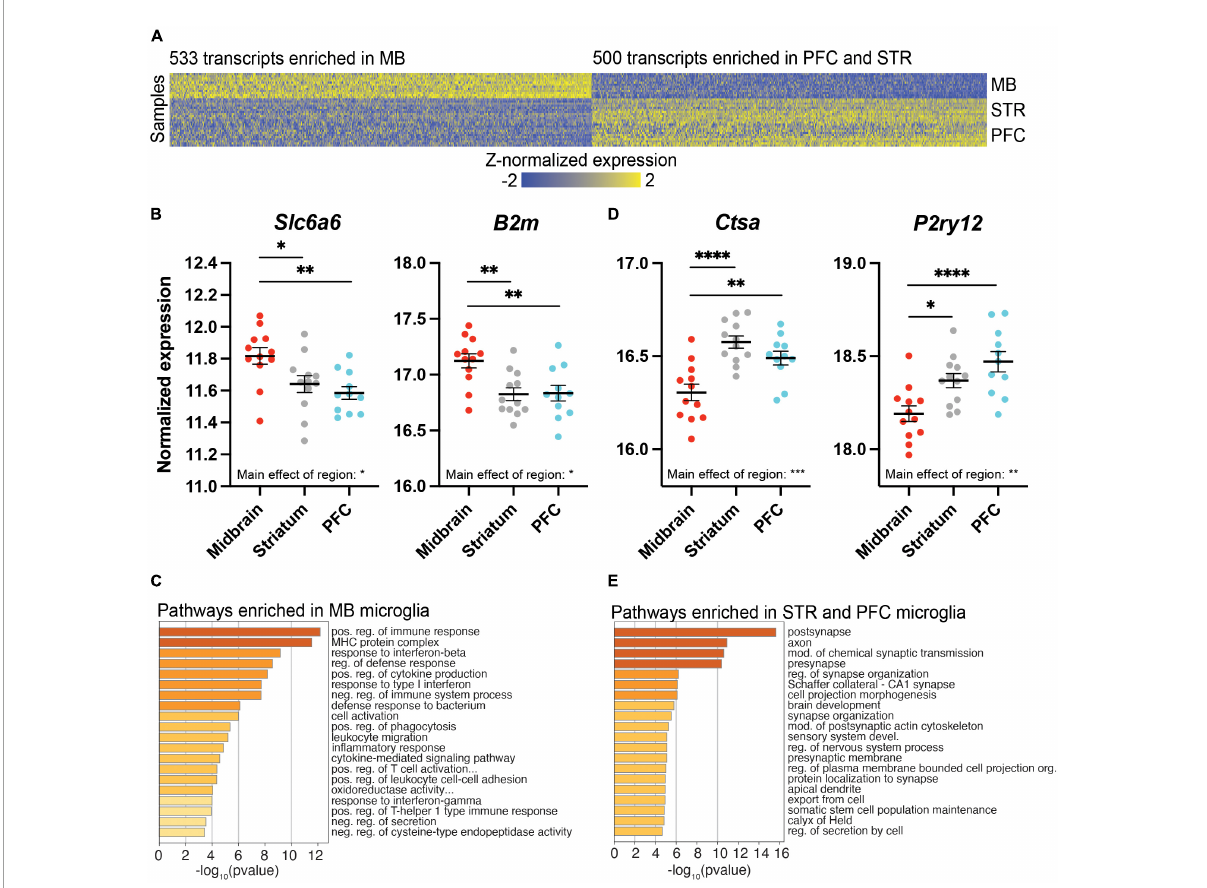
FIGURE3 Differentially expressed (DE) transcripts that distinguish the midbrain (MB) from the prefrontal cortex (PFC) and striatum (STR). (A) Heatmap of DE transcripts between MB and both PFC and STR. The 533 transcripts more highly expressed in MB compared to both PFC and STR are indicated on the left of the heatmap, while the 500 transcripts expressed at lower levels in MB compared to both PFC and STR are indicated on the right of the heatmap. DE transcripts are plotted on the x-axis and individual subject samples on the y-axis. (B) Slc6a6 and B2m fit the pattern of being more highly expressed in MB compared to PFC and STR. (C) Top pathways represented by transcripts expressed more highly in the midbrain compared to PFC and STR. (D) Ctsa and P2ry12 fit the pattern of being expressed at lower levels in midbrain compared to PFC and STR. (E) Top pathways represented by transcripts expressed at lower levels in midbrain compared to PFC and STR. ∗ , p < 0.05; ∗∗ , p < 0.01; ∗∗∗ , p < 0.001; ∗∗∗∗ , p < 0.0001.